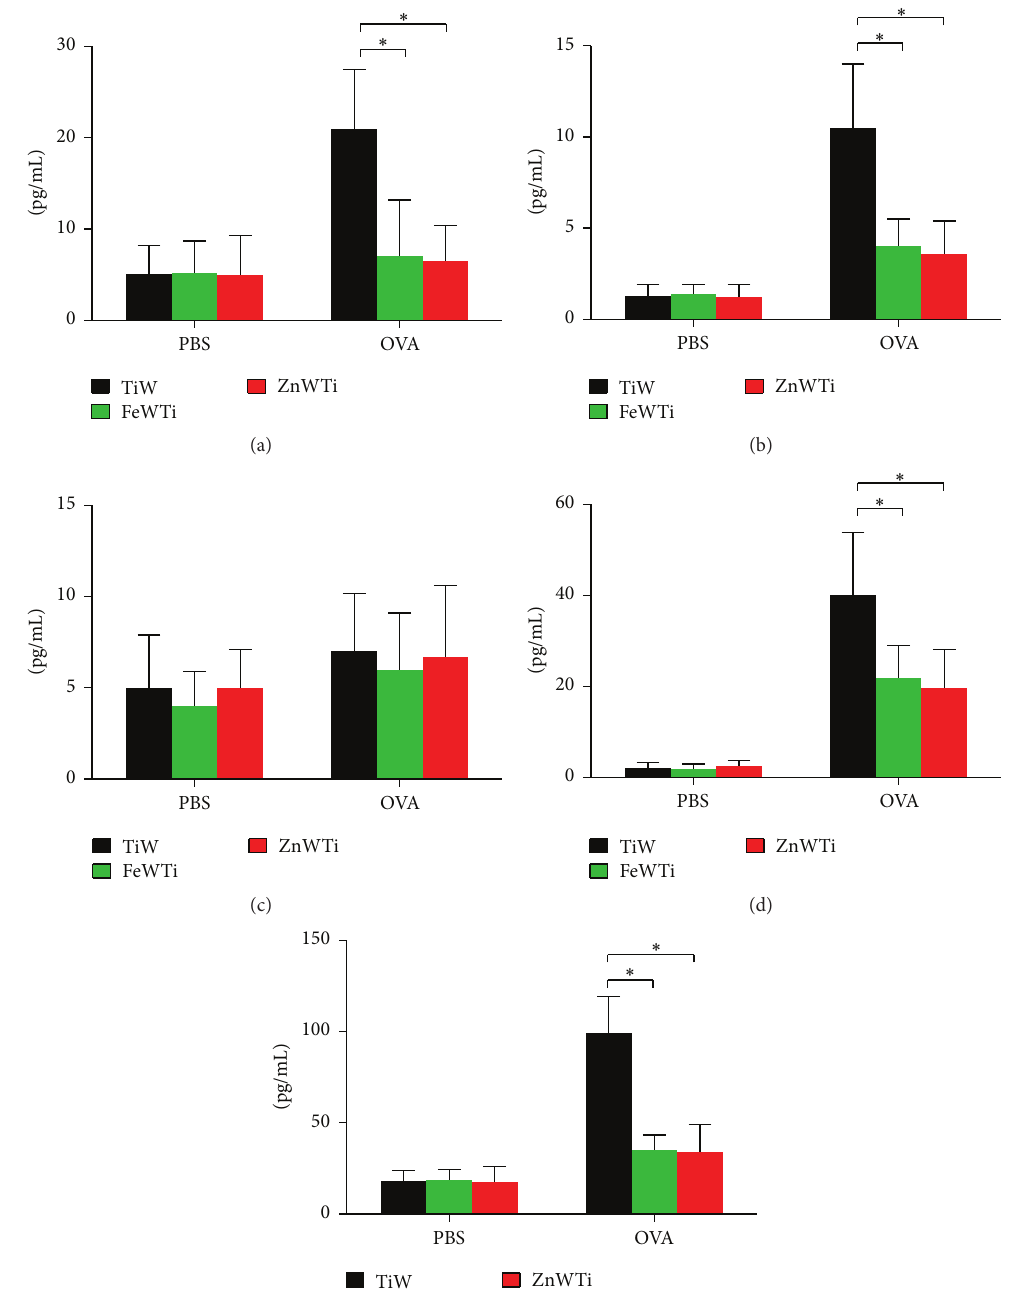
Figure 3: Polyoxometalates FeWTi and ZnWTi reduce inflammatory cytokines profile in OVA-induced asthma. Cytokines in the BALF were measured by ELISA; the concentration of (a) IL-4, (b) IL-5, (c) IFN- 𝛾 , (d) IL-13, and (e) TNF- 𝛼 ; bars = SEM; 𝑛 = 7 mice/group/experiment; ∗ 𝑝 < 0.05 compared to mouse treated with TiW. Data are representative of 3 experiments.